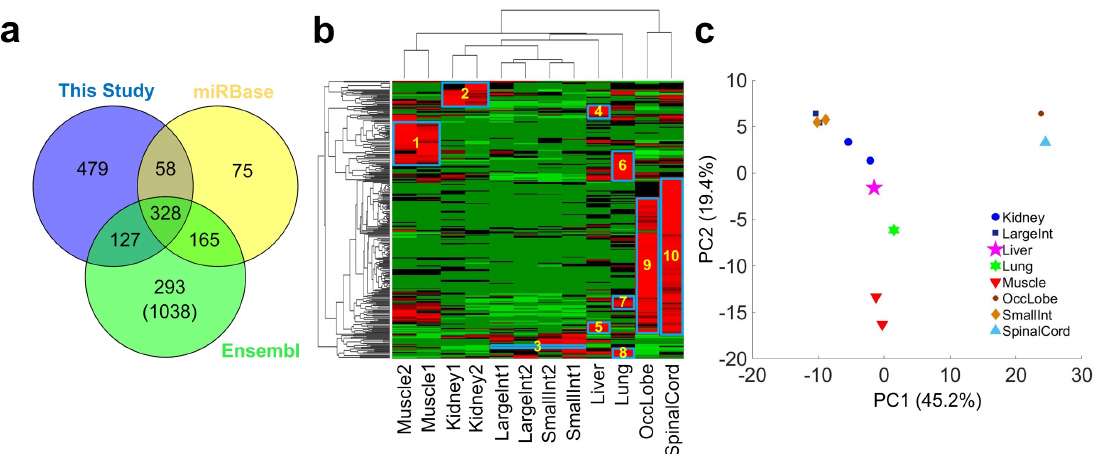
Figure 1. A summary of the identified conserved miRNAs and analysis of their expression patterns in different tissues. ( a ) The number of conserved miRNAs identified in this study and those reported in the miRBase (v22) and the Ensembl database (version Mmul_8.0.1). The 1038 miRNAs in